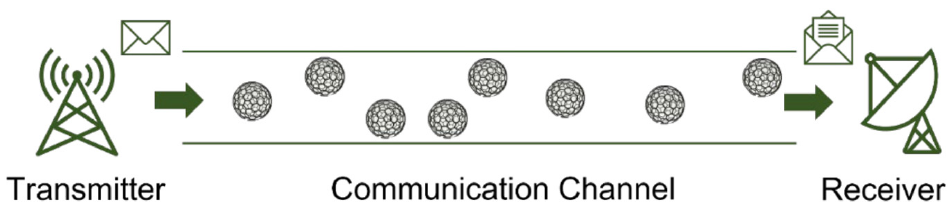
Figure 1. Schematic representation of an artificial molecular communication system considering spherical nanoparticles as information